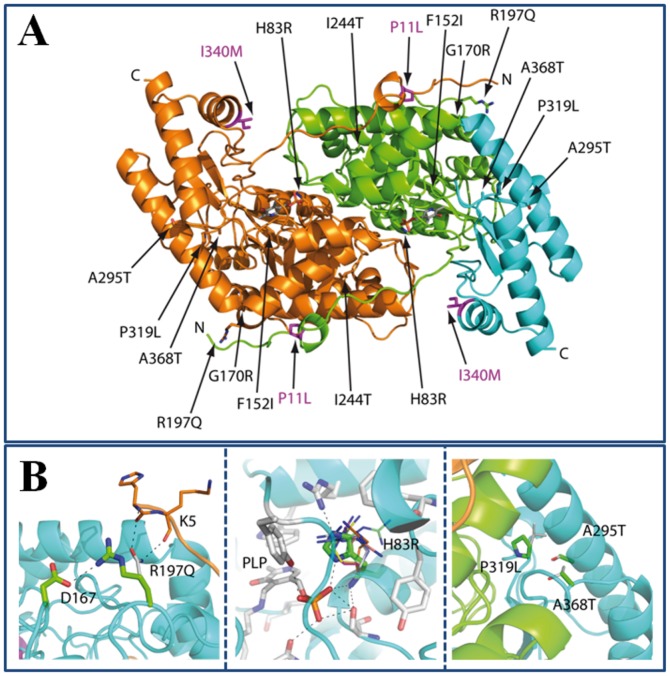
Structural modeling of AGT mutations and polymorphisms.A) Representation of AGT dimer structure. The domain structure of one of the subunits is emphasized using green and blue colors. The AGT mutations found in PH1 patients are labeled and pointed by the arrows while the polymorphisms constituting the minor allele are highlighted in magenta. B) Representation of the structural environment of the Arg197 (left), His83 (middle) and Ala295, Pro319 and Ala368 (right). The mutations have been modeled as thinner sticks.